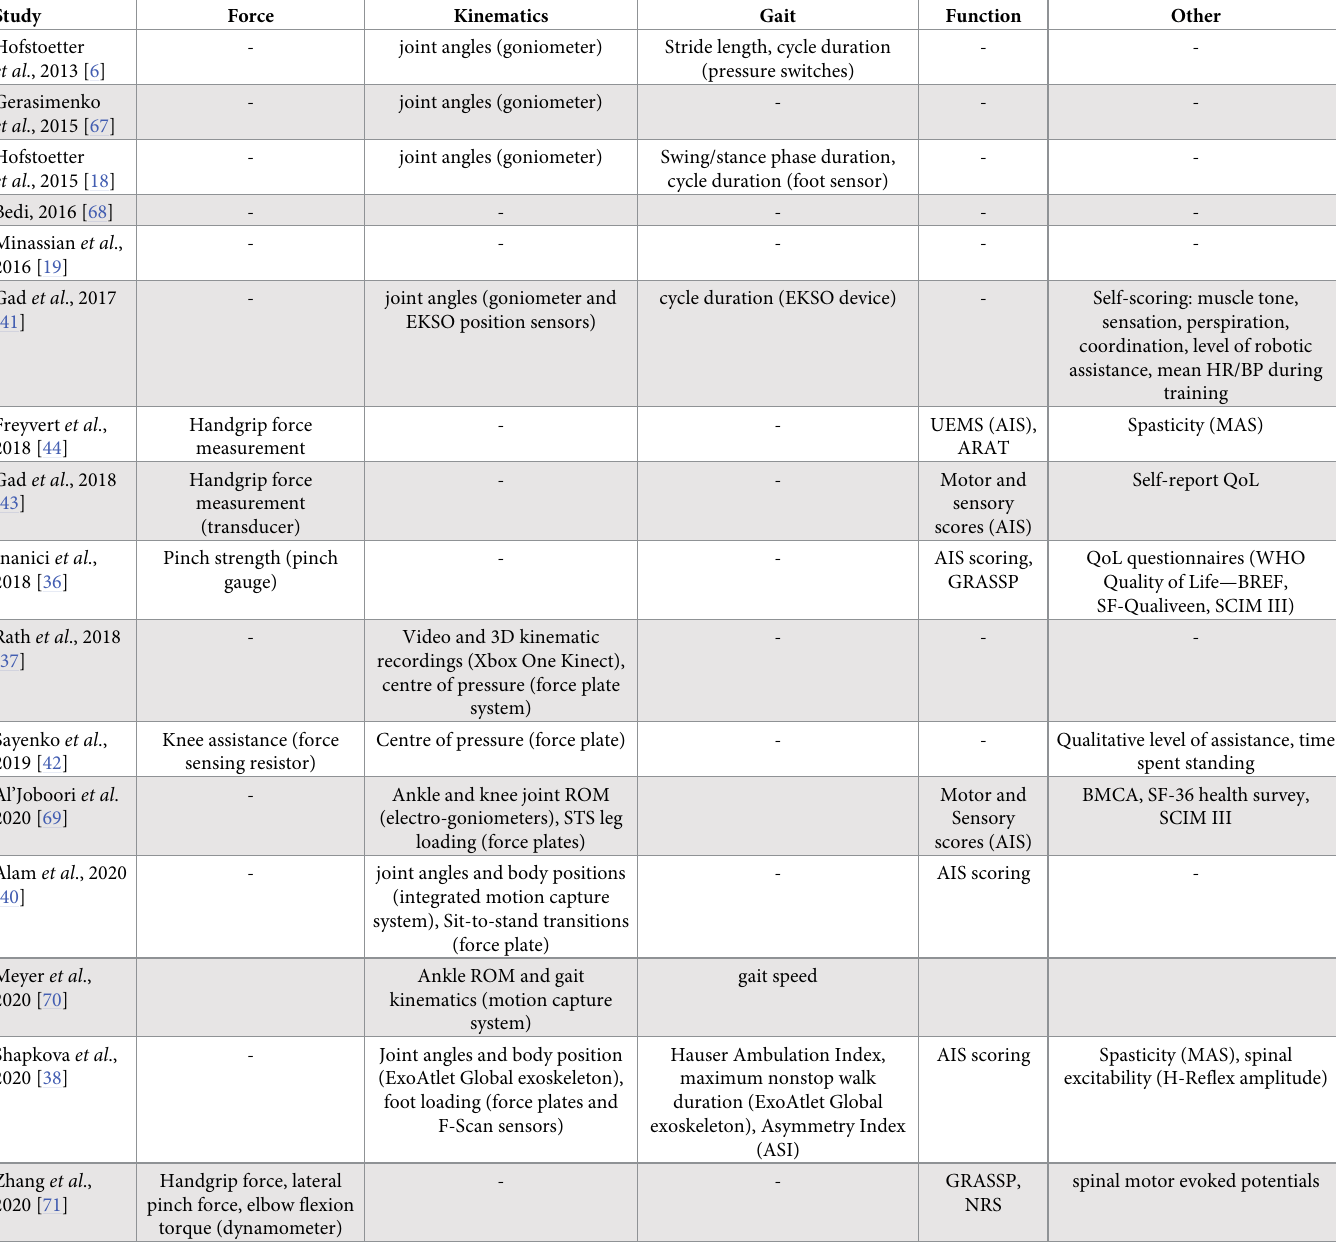
Table 8. Outcomes measures employed by therapeutic studies investigating the outcomes of tSCS on motor rehabilitation in individuals with SCI. Outcomes selected in the included studies evaluating the effects of therapeutic transcutaneous spinal cord stimulation in spinal cord injured